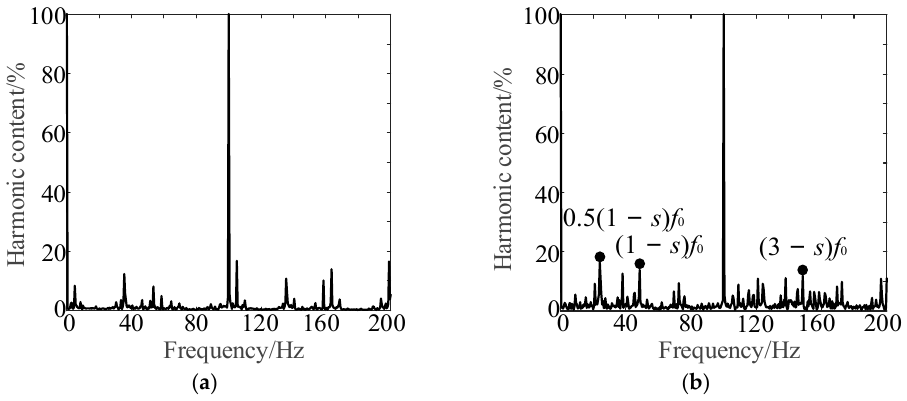
Figure 3. The spectrum comparison of current signal. ( a ) Normal motor; ( b ) faulty motor with broken rotor bars.